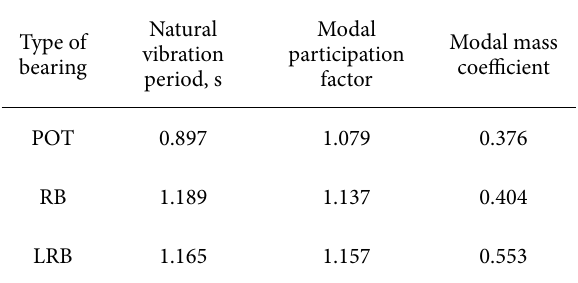
Table 5. Dynamic characteristics of mode 1 piers according to the eigenvalue analysis